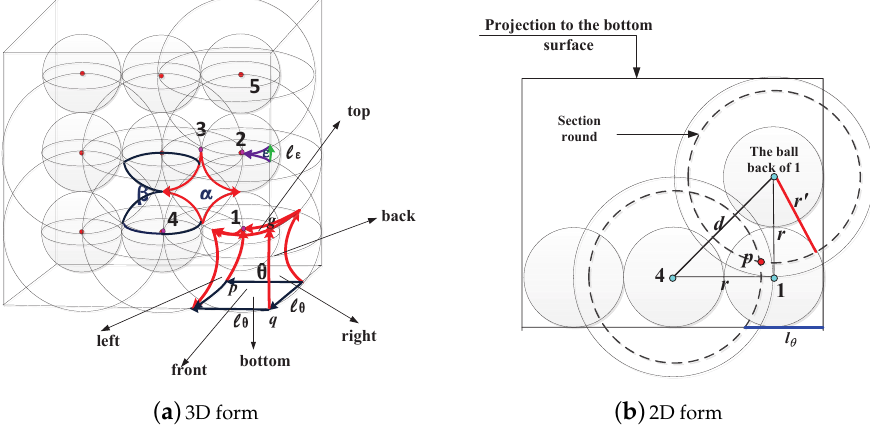
Figure A1. Tangent deployment of two-equivalent radius spheres. ( a ) 3D form; ( b ) 2D